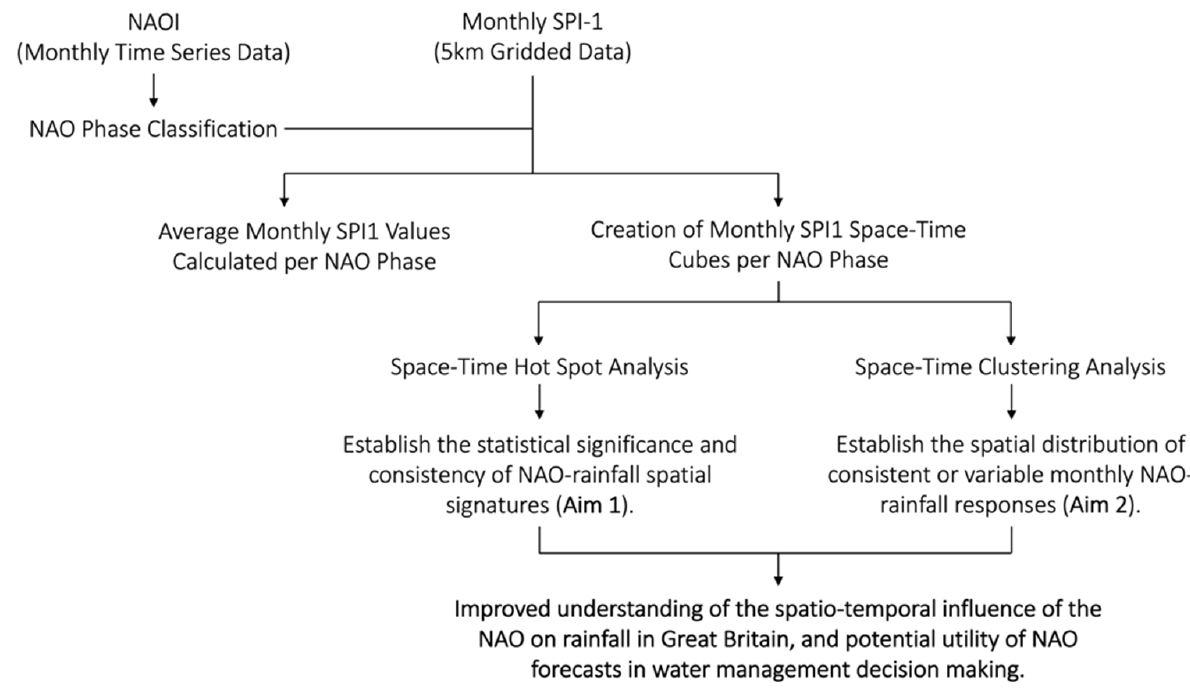
Figure 1. Flow chart of the analytical stages of this study.